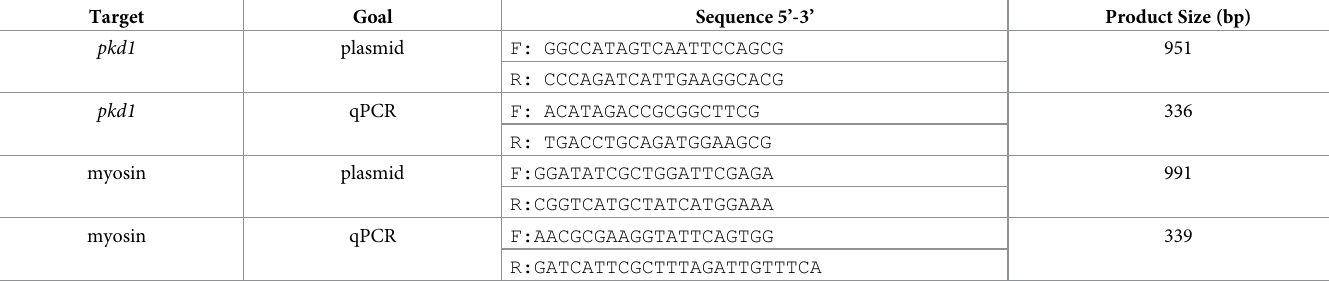
Table 1. Primer sequences for quantitative and conventional PCR for both host and parasite used in this study.